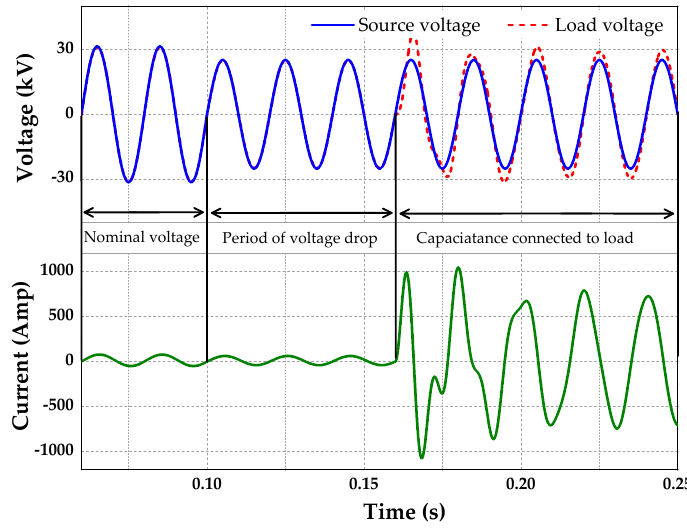
Figure 7. Dynamic behavior of output voltage and current.